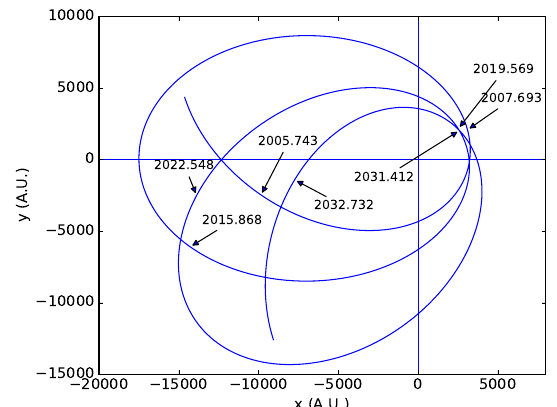
Figure 3. The typical orbit of the secondary BH in OJ 287 in 2005–2033 window. The primary BH (Schwarzschild radius R S ∼ 362 AU) is situated at the origin with its accretion disk in the y = 0 plane. The average distance of periastron is ∼ 9 R S and the binary is going to merge within 10,000 years. The locations of the secondary BH at the time of different outburst epochs are marked by arrow symbols. The time-delay effect is clearly visible, while close inspection reveals that these delays for different impacts are different [9]. ©AAS